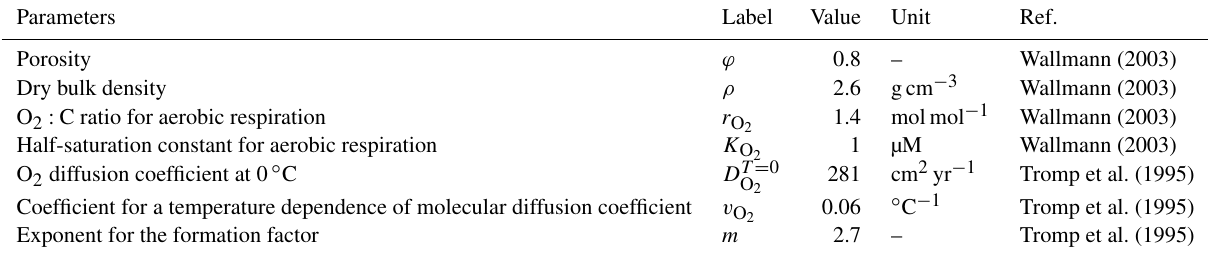
1.4 molmol − 1 Wallmann (2003) 2 2